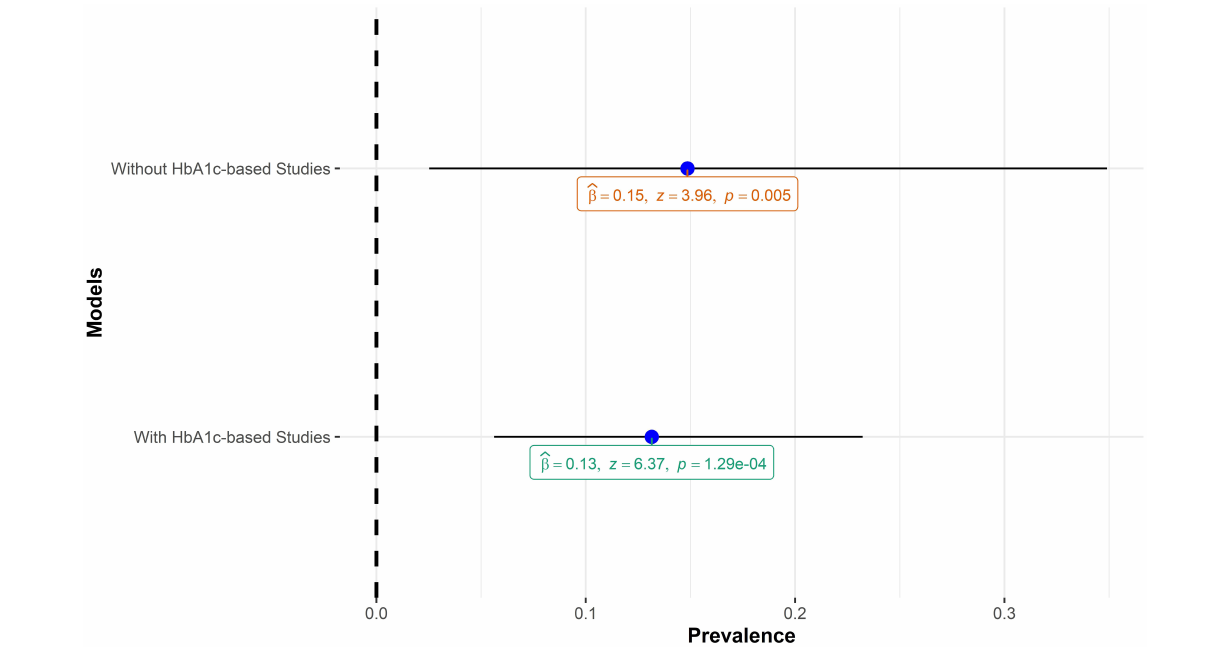
Frontiers in Public Health |